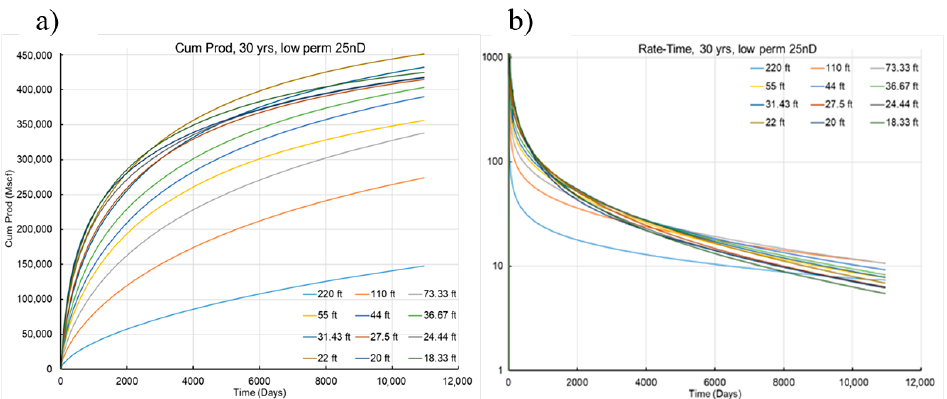
Figure A3. Production performance of Utica wells for well spacing ranging between 300 and 2300 ft. The base case performance is for the Utica type well with 55 ft fracture spacing and an assumed 1100 ft well spacing. The impact of wider and narrower well spacing on well productivity is graphed for both ( a ) the cumulative, and ( b ) daily production rates. Well performance curves were generated with a numerical reservoir simulator by ResFrac (data from Reference